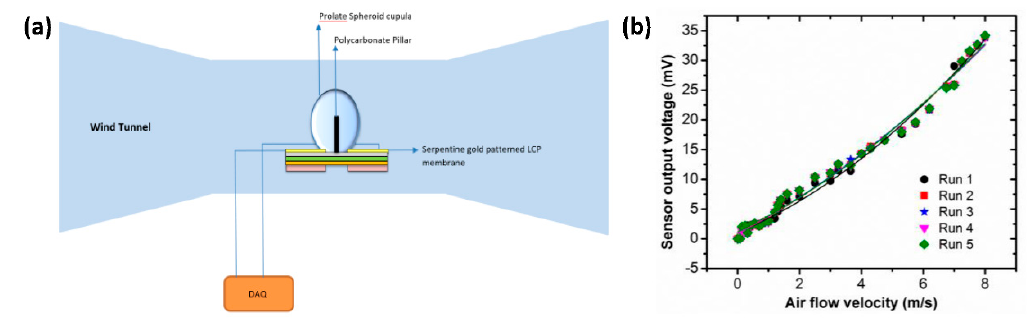
Figure 3. ( a ) Schematic representation of the experimental setup for testing the steady-state response of biomimetic MEMS SN sensor. ( b ) Plot showing the responses of the biomimetic MEMS SN sensor when subjected to a steady state flow over a velocity range of 0–8 m/s